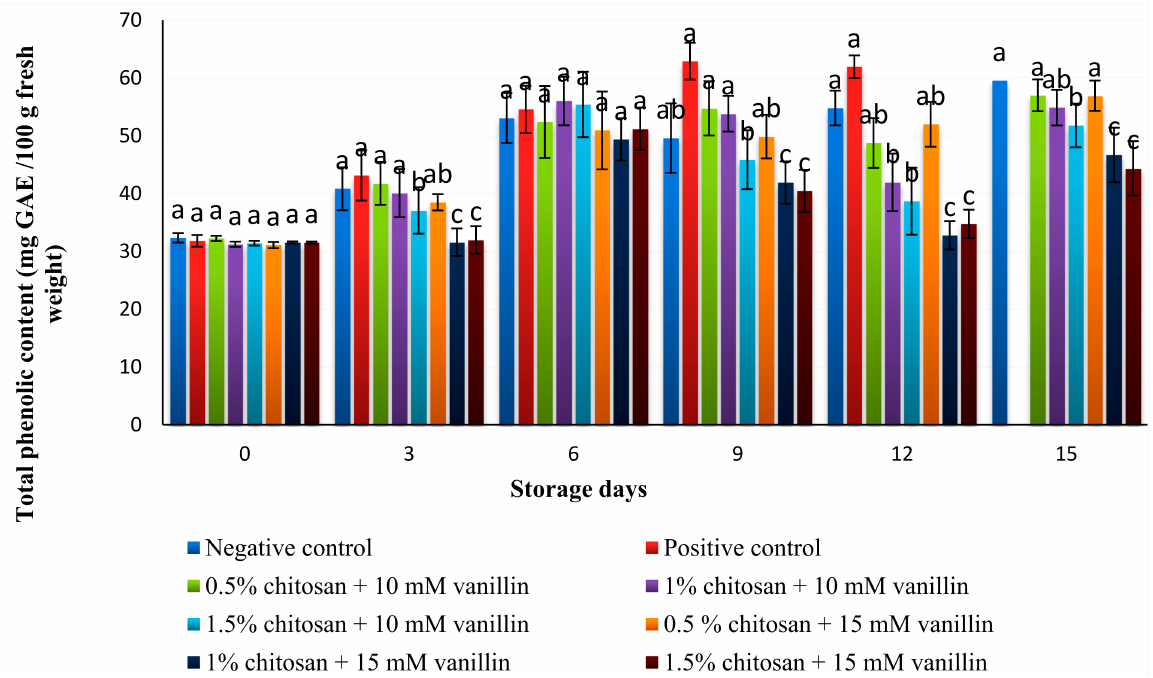
Figure 5. Effects of coating treatment on total phenolic content in Fusarium oxysporum inoculated tomato fruit stored for 15 days at 26 ± 2 ◦ C and 60 ± 5% relative humidity. Mean values in a column followed by different letters for each storage day differed significantly by LSD at p ≤ 0.05. Vertical bars indicate standard error of means ( n =